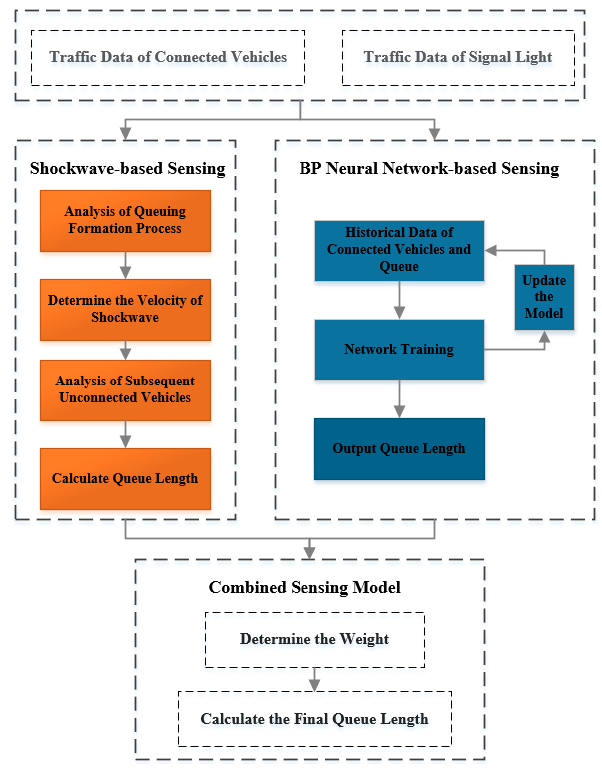
Figure 1. The overall structure of the sensing model.